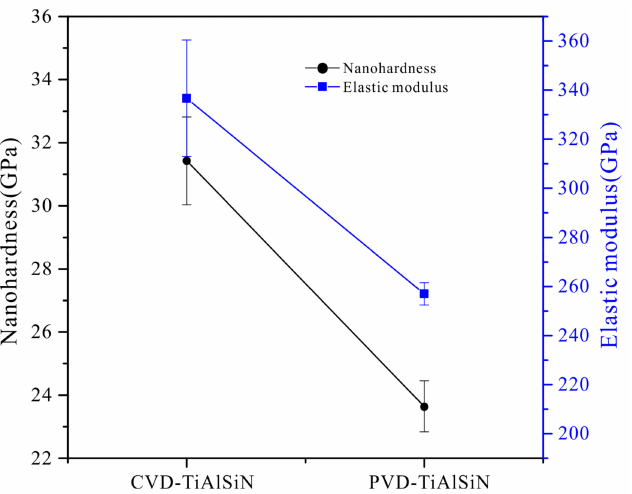
Figure 7. The hardness and elastic modulus of CVD Ti 0.13 Al 0.85 Si 0.02 N and PVD Ti 0.31 Al 0.60 - Si 0.09 N